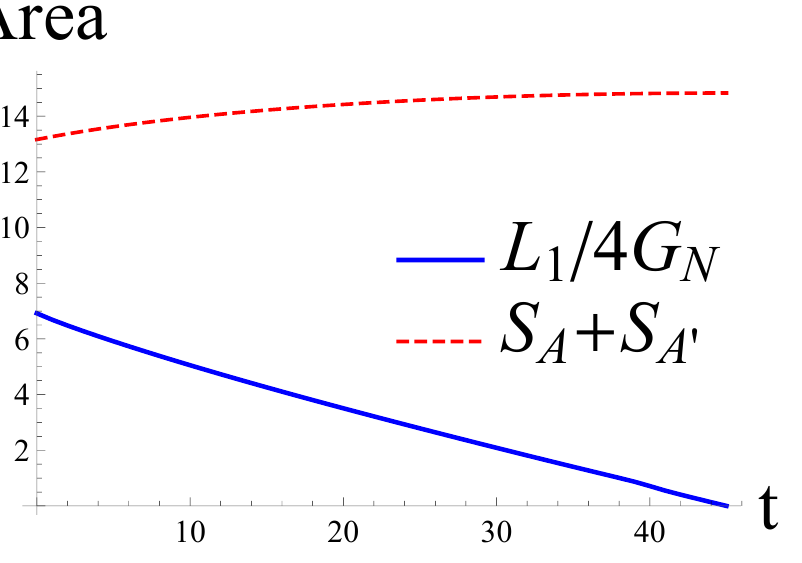
Figure 6 . A numerical plot of S AA 0 = L 1 / 4 G N (blue line) and an analytical plot of S A ( t ) + S A 0 ( t ) (red dashed line) with the same choice of parameters as figure 5. Clearly at the end of the deco- herence process at t = 45 , L 1 goes to zero. For the illustration of the geometry, see figure 7 as